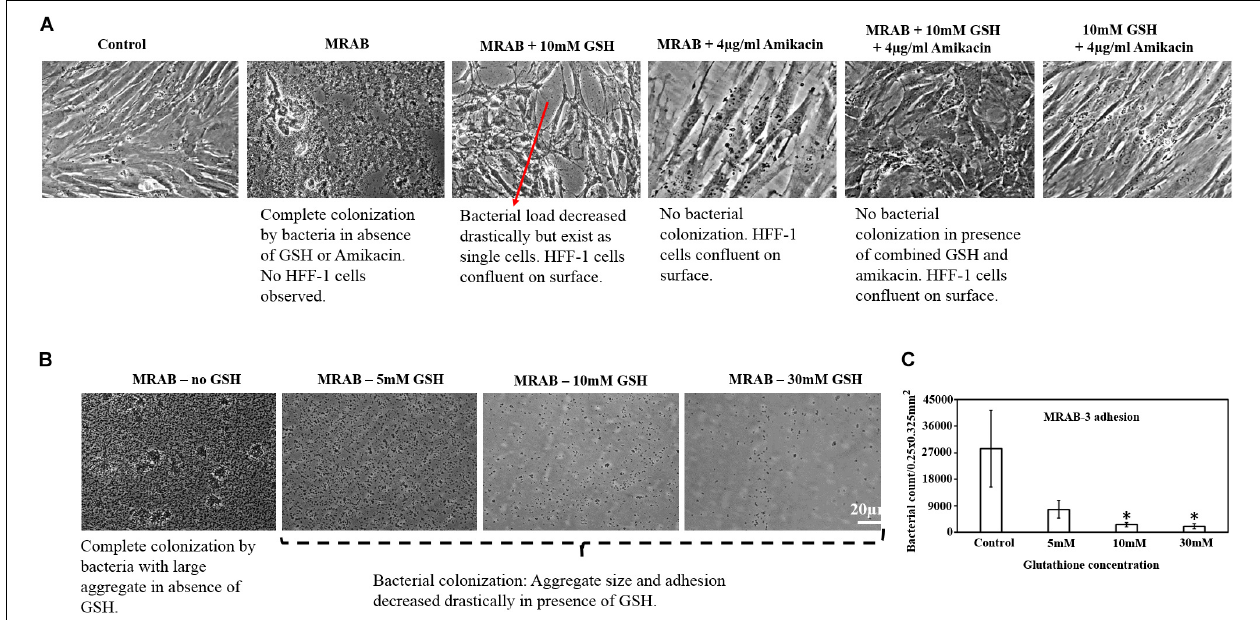
FIGURE 7 | Effect of GSH on MRAB colonization and HFF-1 confluence. (A) Pre-confluent HFF-1 cells were completely disrupted when exposed to MRAB-3, whereas GSH, amikacin alone or in combination, inhibited MRAB colonization and retained HFF-1 cell confluence. (B,C) GSH alone was shown to significantly decrease MRAB-3 adhesion and colonization. ∗ P < 0.05 compared to control and data represent the mean ± SD of n = 3 experiments performed in biological